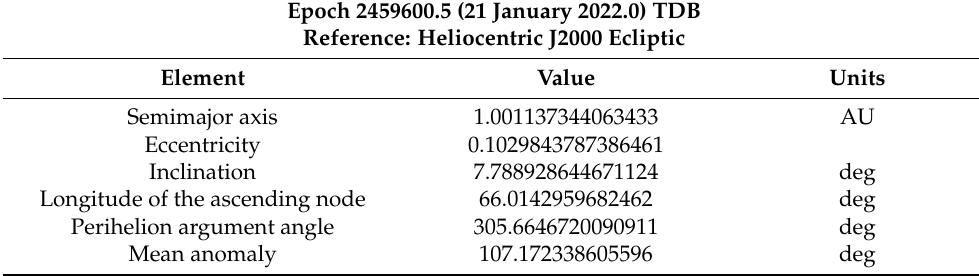
Table 2. Orbit elements of 2016HO3.